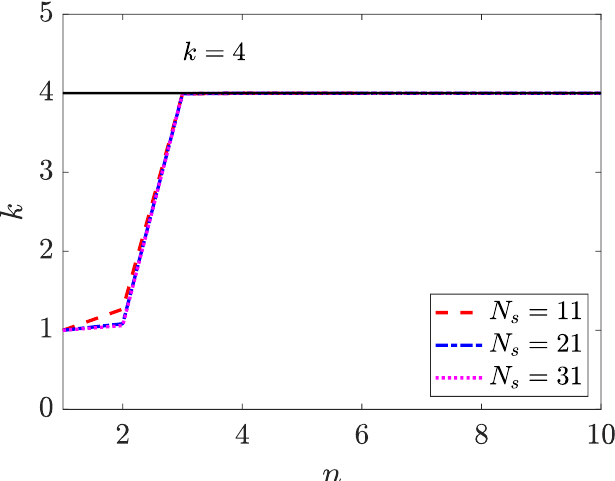
k with iteration steps for the 1D constant parameter identifi-